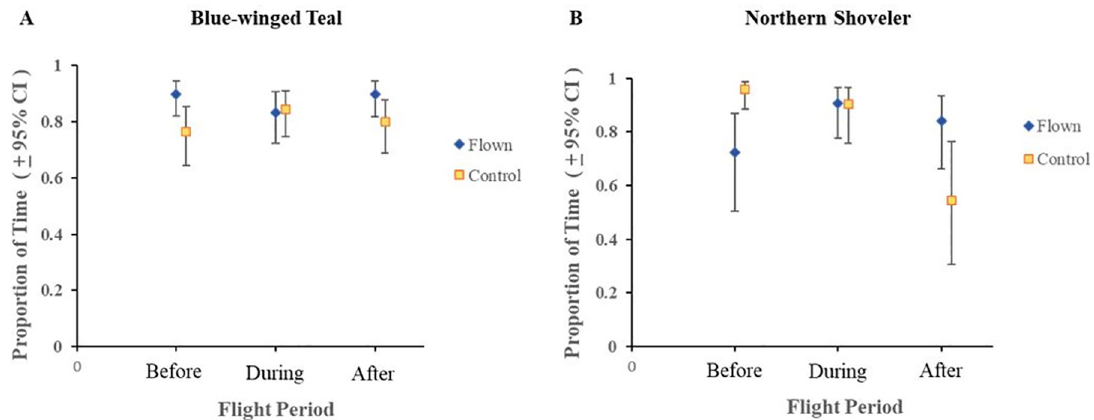
Fig 1. Least square means and 95% confidence intervals of proportion of time spent on active behavior for blue-winged teal (A) and northern shoveler (B) within treatments groups (Flown vs. Control). Additional behaviors for active are feeding, breeding, preening, and swimming.